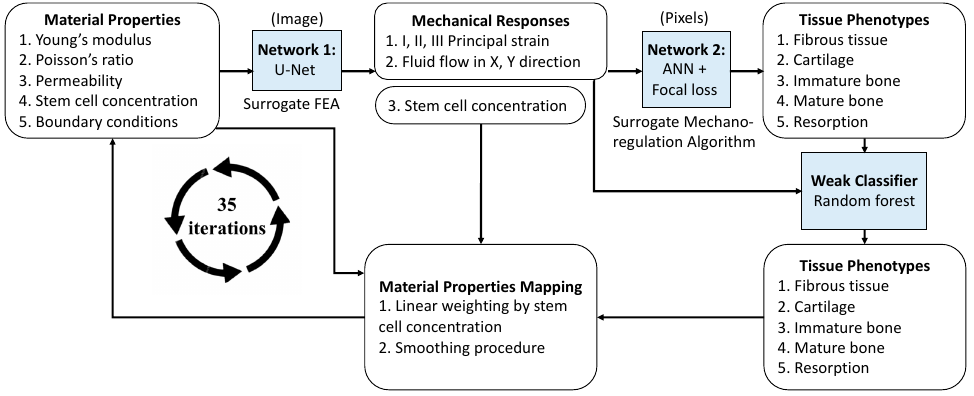
Figure 1. The framework of the deep-learning-based network of short-term bone healing prediction. Secondly, Network 2 (artificial neural network, ANN) aimed to replace the mechano- regulation algorithm, which classifies the differentiated tissue phenotypes based on the mechanical responses obtained from Network 1. Note that the prediction of ANN architec- ture is pixel-wise, and the dimensions of the input and output in Network 2 are both 1 × 5. The input of Network 2 includes principal strains I, II, and III, and fluid flow in X and Y directions, while the output is the probability of being classified as each tissue phenotype (fibrous tissue, cartilage, immature bone, mature bone, and resorption). Note that the stem cell concentration was not included in the training of Network 2 because it is assumed that the diffusion of the stem cell is independent of the tissue differentiation. On the other hand, the focal loss function [25] was adopted to address the issue of data imbalance because it was found that 90% of the tissue was mature bone. The parameters in the function were determined based on Bayesian optimization